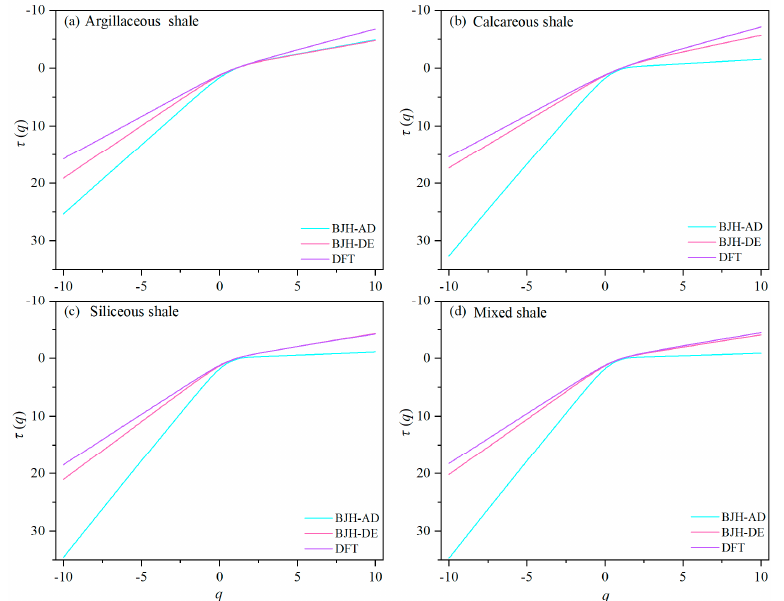
Figure 7. Variations of the mass distribution function τ ( q ) of different BJH and DFT models obtained from the N 2 adsorption experiments. ( a ) τ ( q ) of argillaceous shale; ( b ) τ ( q ) of calcareous shale; ( c ) τ ( q ) of siliceous shale; ( d ) τ ( q ) of mixed shale